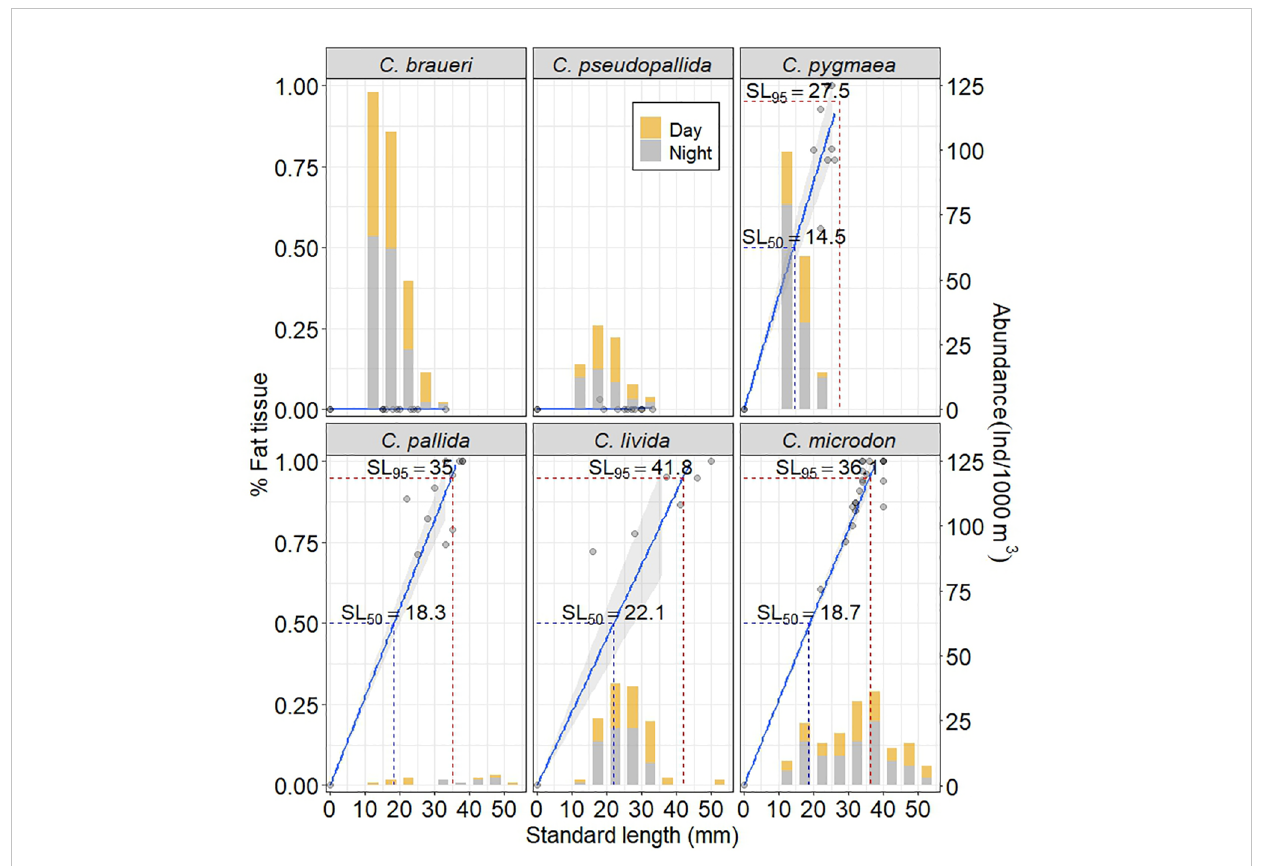
FIGURE 4 Linear regression model fi t predicting the percentage of fat tissue in Cyclothone spp. swimbladders from standard length (mm) assuming zero percentage at the origin (left vertical axis) and size frequency distribution (right vertical axis). SL 50 , half- fi lled swimbladder of fat tissue (50%); SL 95 , lipid-full swimbladder (95%).